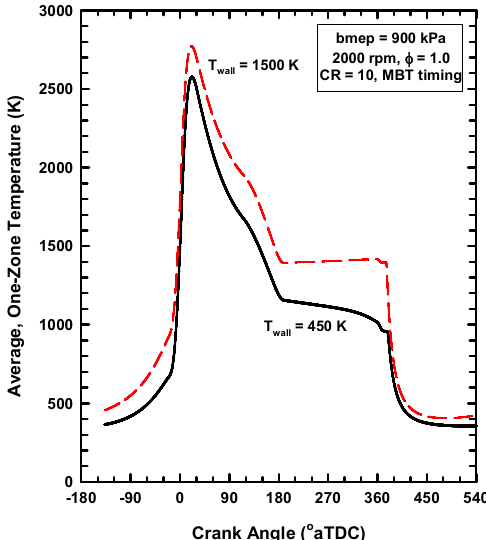
Figure 5. Average, one-zone cylinder gas temperatures as functions of crank angle with cylinder wall temperatures of 450 and 1500 K.